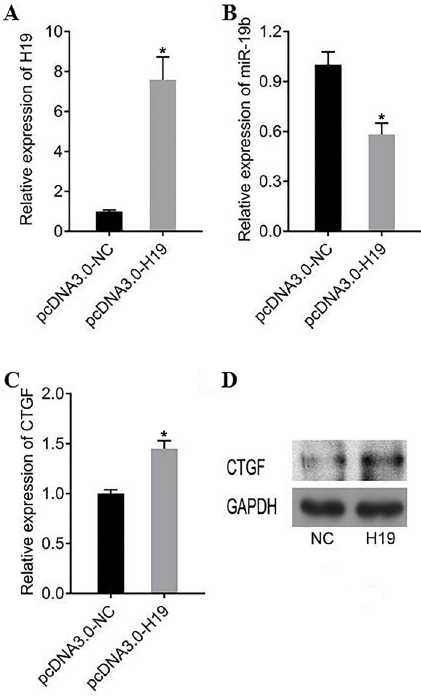
Figure 2. A , H19 expression after overexpression of H19 . B , Expression of miRN- 19b after overexpression of H19 . C and D , CTGF expression after overexpression of H19 . Data are reported as means ± SD. *P o 0.05 compared to negative control (NC) ( t -test).